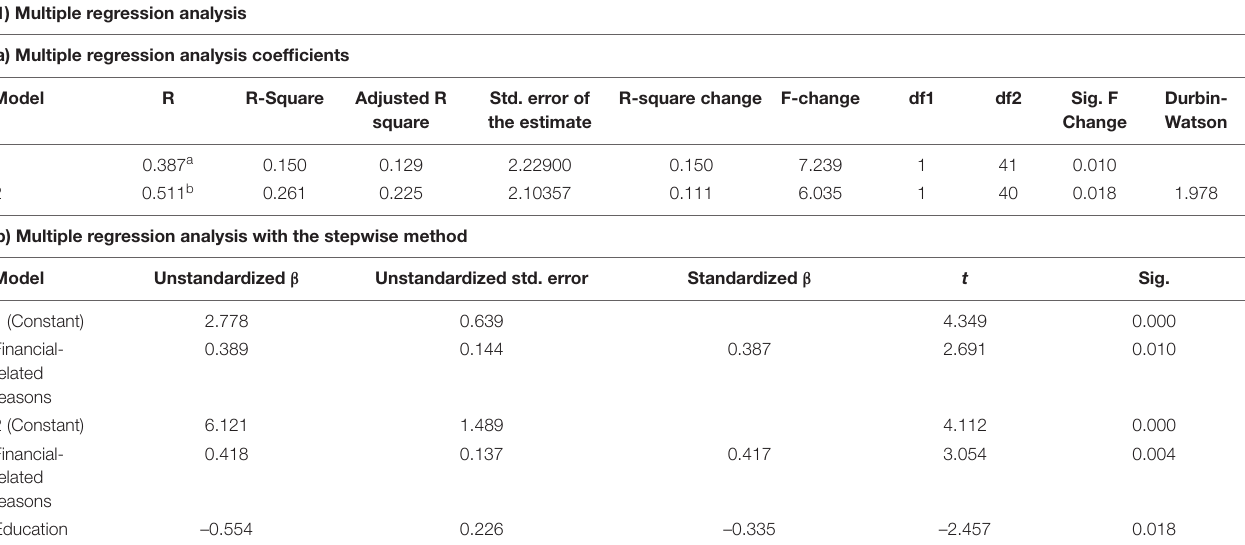
TABLE 3 | Multiple regression analysis coefficients and multiple regression analysis with the stepwise method. Methods